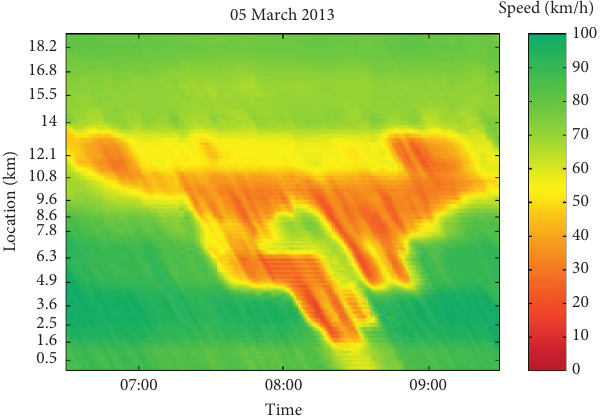
Figure 3: Speed field as a function of space and time, for the morning peak hours of a typical day.